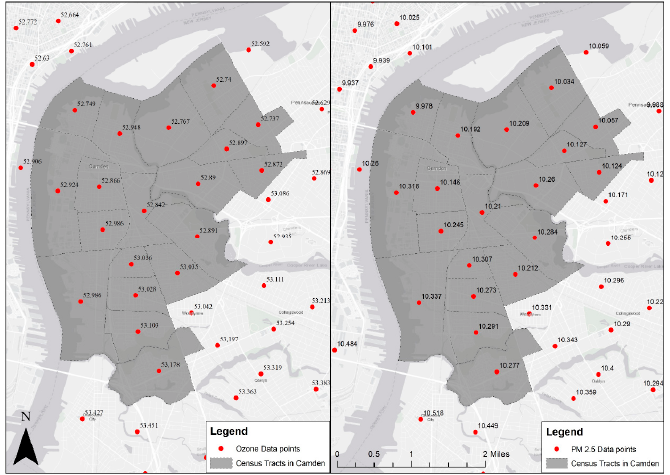
Figure 6. Community Multiscale Air Quality (CMAQ) data downscaled to centroid points of the census tracts: ( left ) ozone concentration in ppb; ( right ) PM 2.5 concentration in µg/m 3 .